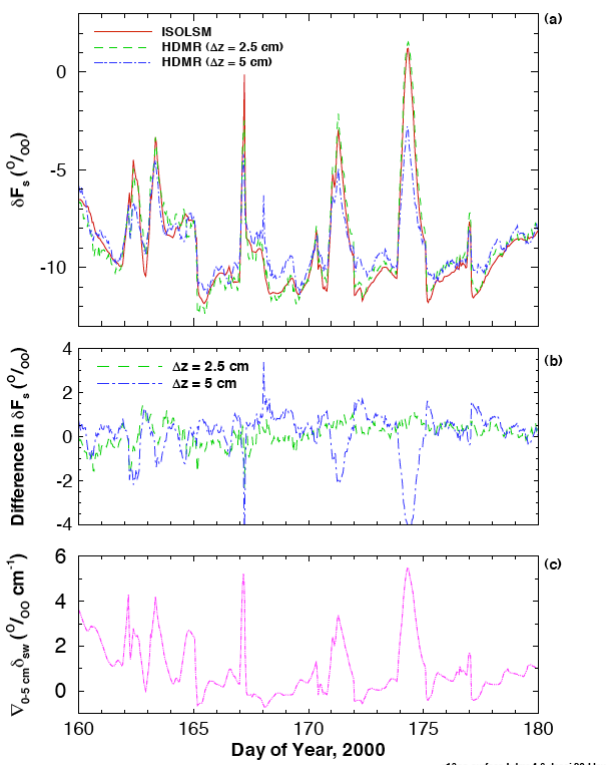
Fig. 3. (a) Same as in Fig. 2, but for a 20-day period. Also shown Figure 3. (a) Same as in Figure 2, but for a 20-day period. Also shown are (b) differences 2 are (b) differences between the full ISOLSM model results and the between the full ISOLSM model results and the HDMR predictions for Δ z = 2.5 and 5 3 HDMR predictions for 1z = 2 . 5 and 5cm and (c) ∇ 0 − 5cm δ sw , the predicted gradient in δ sw over the top 5cm of soil. Differences be- tween scenarios D 1 and D 2 are largest when near-surface δ sw gradi- ents are large. Discretization scenario D 1 more accurately predicts the impact of these gradients on δF s since this HDMR solution is based on the identical spatial discretization as that of the ISOLSM simulation (i.e., 2.5cm in the top 20cm of soil).